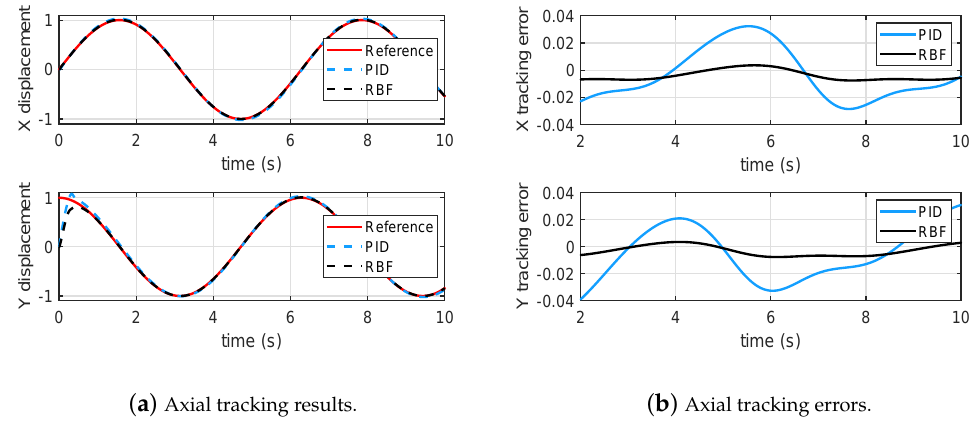
Figure 8. Tracking of a circular trajectory.